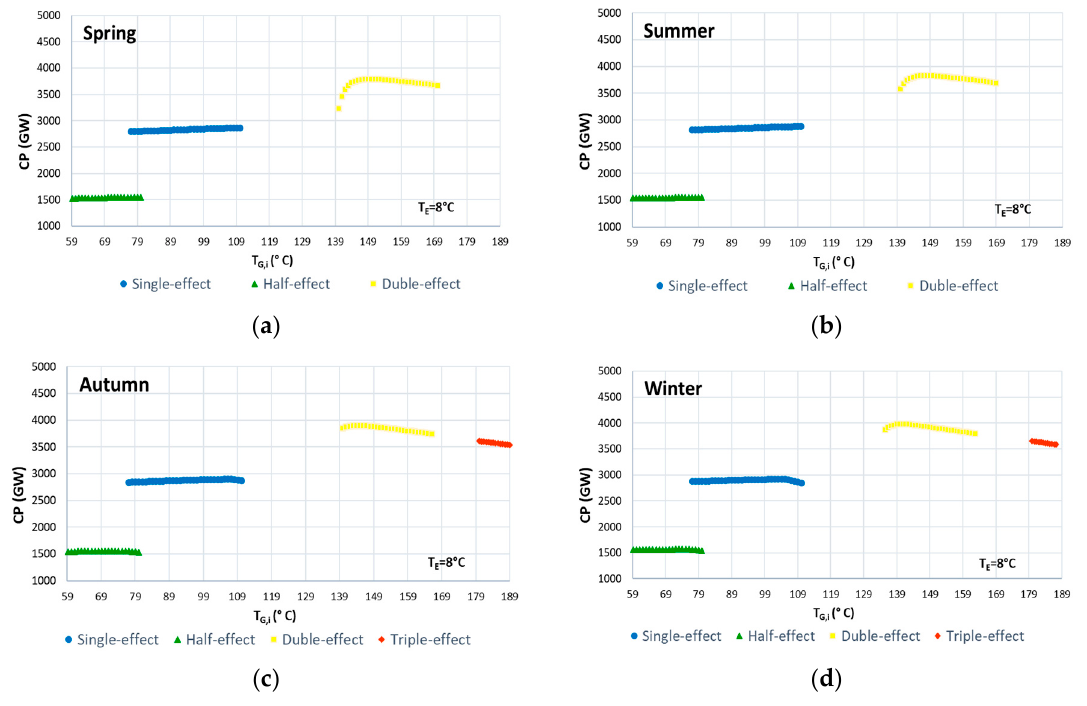
Figure 12. Cooling Potential per hour for each absorption system for the season, ( a ) Spring, ( b ) Sum- mer, ( c ) Autumn, and ( d ) Winter.